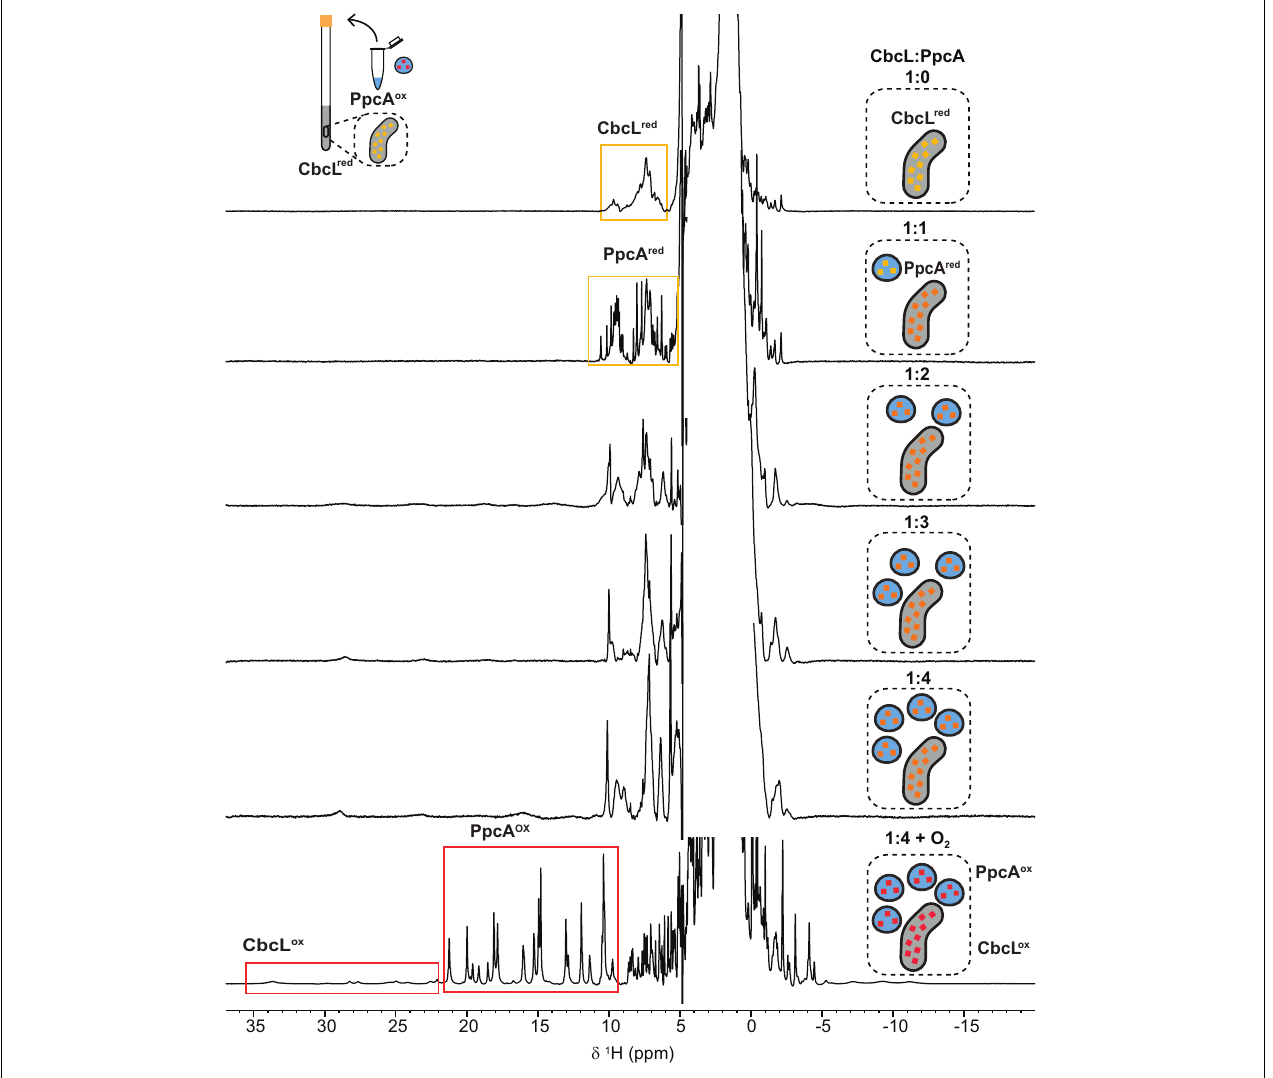
FIGURE 5 | Monitorization of the electron transfer reaction between cytochromes CbcL and PpcA by NMR. 1D 1 H NMR spectra were acquired at 25 ◦ C with 100 µ M of CbcL in 10 mM sodium phosphate pH 8 with increasing equimolar amounts of PpcA, up to 1:4 ratio. The rectangles highlight the cytochromes’ fingerprints in the reduced and oxidized states. The schemes represent the addition of equimolar amounts of oxidized PpcA (blue) to the NMR tube containing initially reduced CbcL (yellow). Red represents fully oxidized states, yellow fully reduced states, and intermediate redox states are represented in orange.